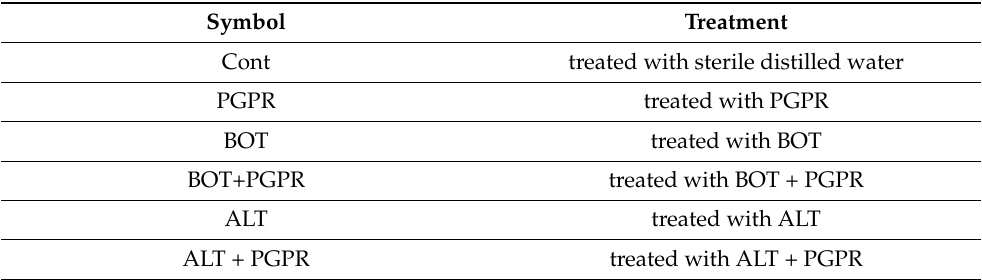
Table 1. Experimental work plan. Symbol Treatment Cont treated with sterile distilled